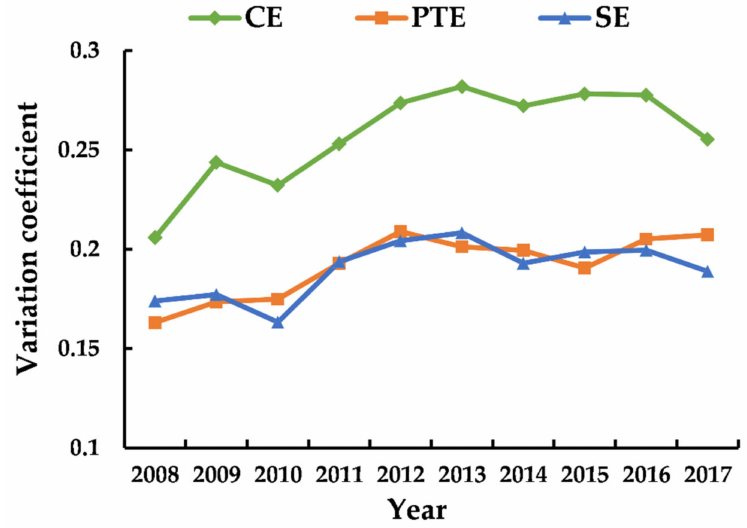
Figure 3. Variation coefficient of tourism eco-efficiency in the Yangtze River Delta urban